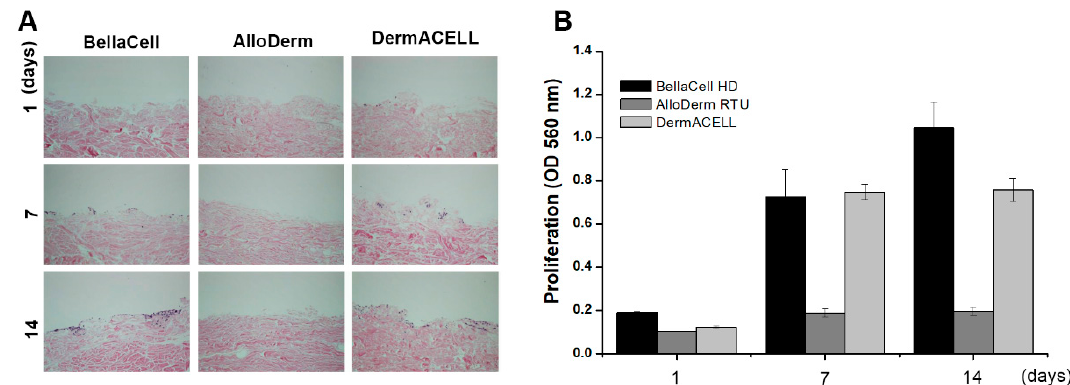
Figure 2. Biocompatibility assessment. ( A ) Cell adhesion on the surface of ADMs was observed under microscope after staining with H&E ( B ) Cell proliferation was evaluated by a 3-(4,5-dimethylthiazol- 2-yl)-2,5-diphenyltetrazolium (MTT) assay. Cell adhesion and proliferation in a span of 1, 7, and 14